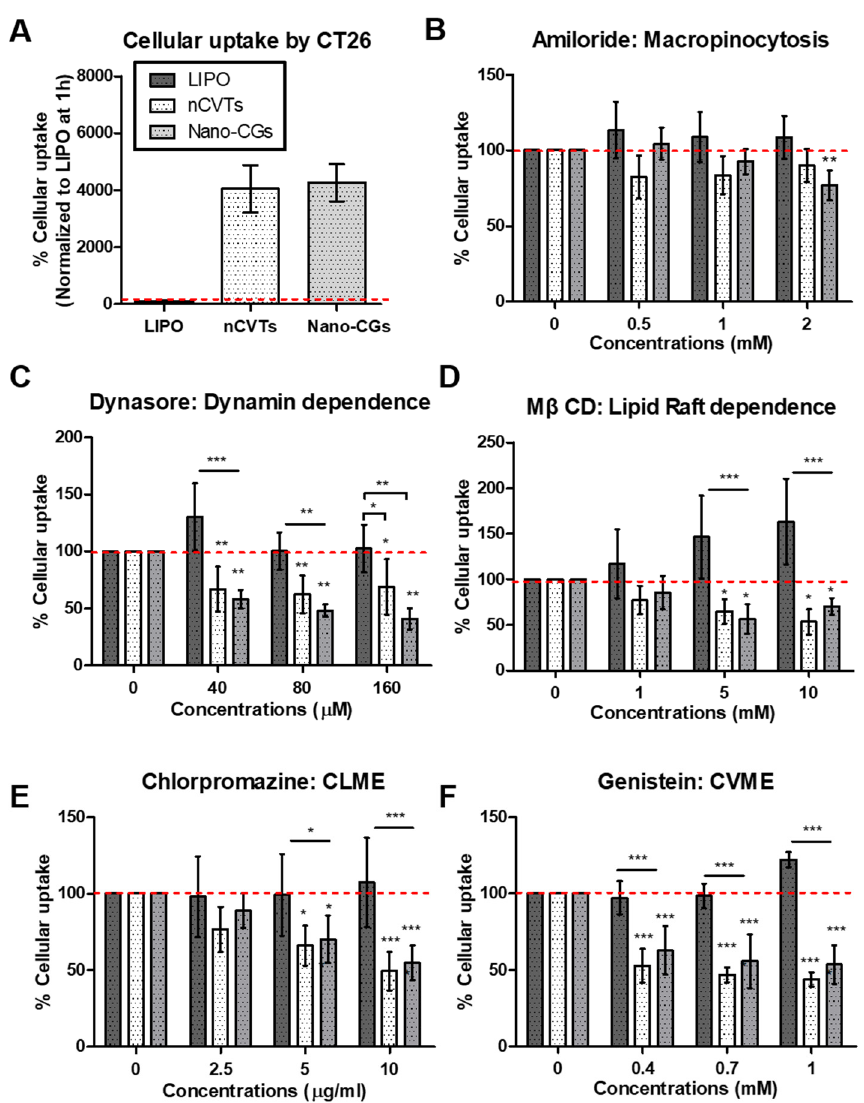
Figure 6. Cellular uptake of liposomes (LIPOs) nCVTs and nan-CGs by CT26 cells ( A ) in the absence of inhibitors and the presence of ( B ) amiloride, ( C ) dynasore, ( D ) methyl- β cyclodextrin (M β CD) ( E ) chlorpromazine, and ( F ) genistein; ( n = 5/group) * p < 0.05, ** p < 0.01, and *** p < 0.001.